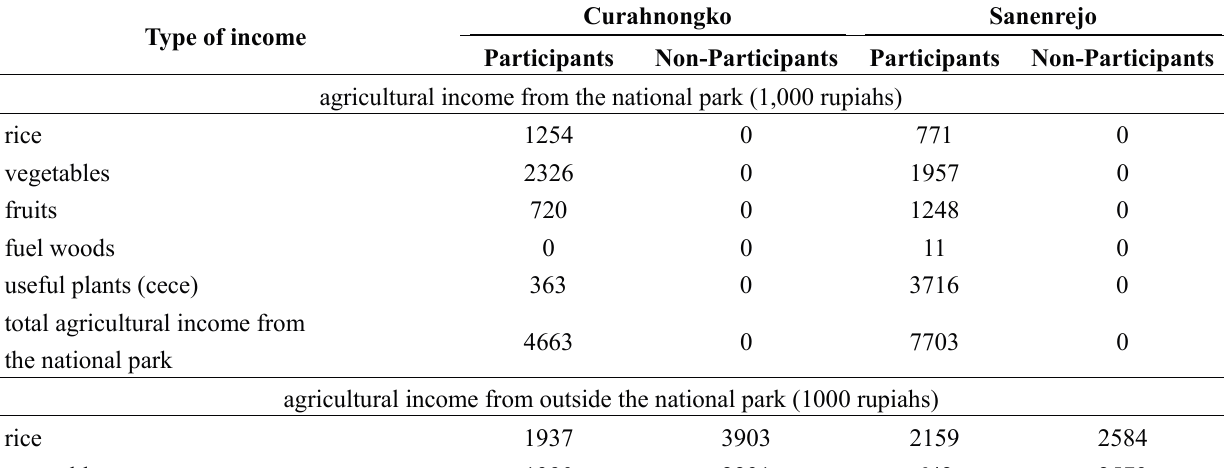
Table 2. Incomes of participants and non-participants in the rehabilitation